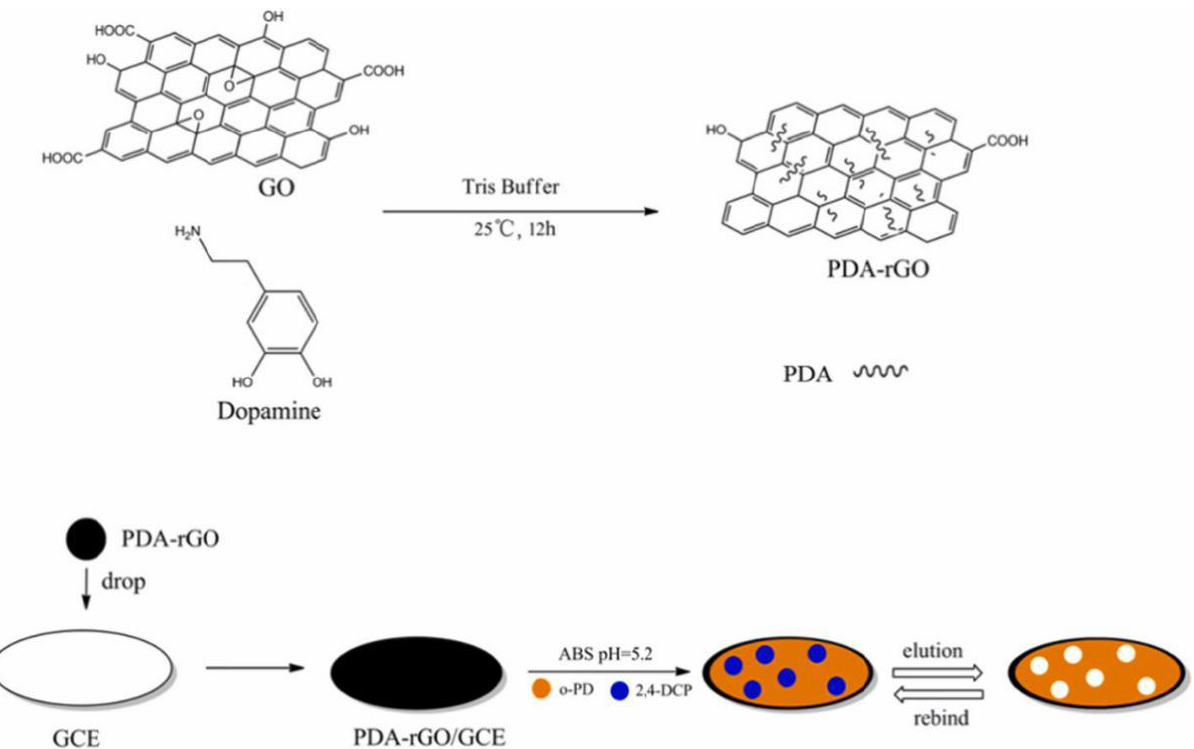
Figure 10. Schematic illustration of the electrochemical sensor for selective detection of 2,4-DCP. Adapted with permission from Ref. [122]. Copyright 2019, Elsevier. Table 5. Detection of heavy metal ions by different MIP electrochemical biomimetic